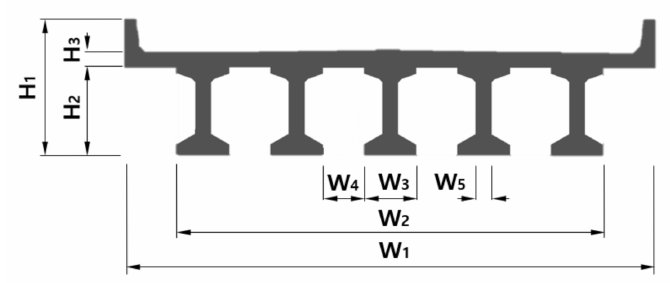
Figure 10. Design parameters for a beam girder bridge.